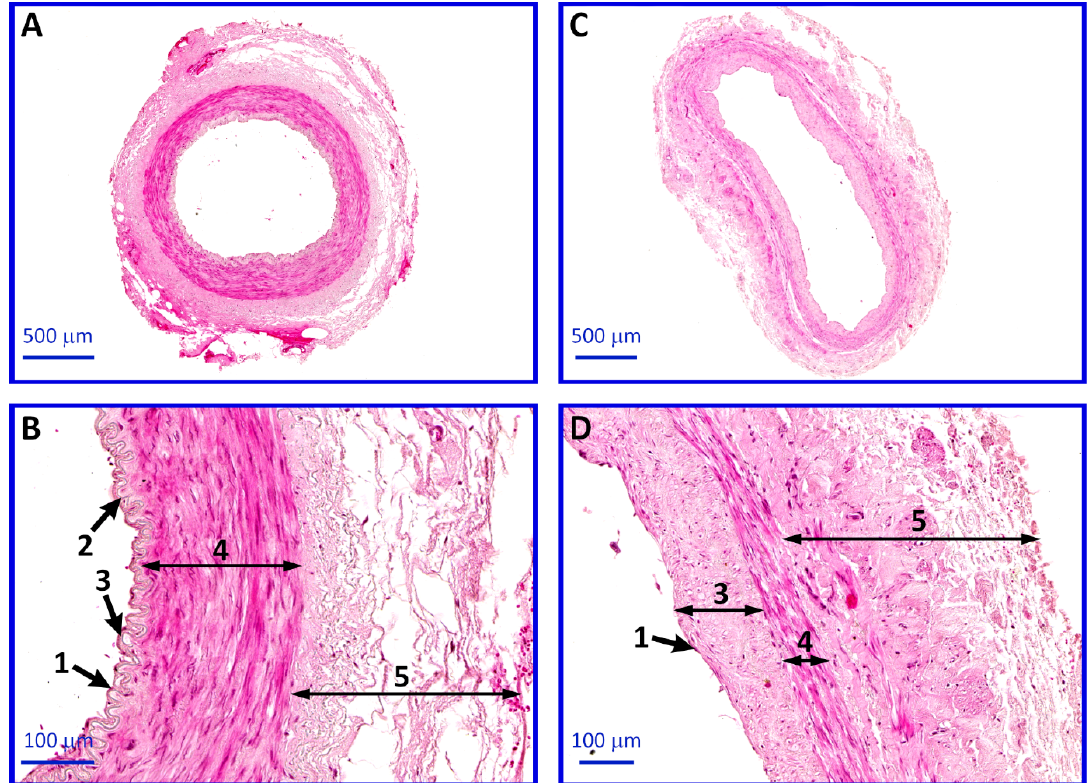
Figure 8. Photomicrograph representing the histological structure of internal thoracic artery (ITA; A , B ) and saphenous vein (SV; C , D ) segments stained with routine hematoxylin and eosin (H&E) staining. The differences in histological structure can be observed. SV is characterized by a thicker tunica adventitia and subendothelial layer compared to ITA. Arrows: 1—endothelium, 2—internal